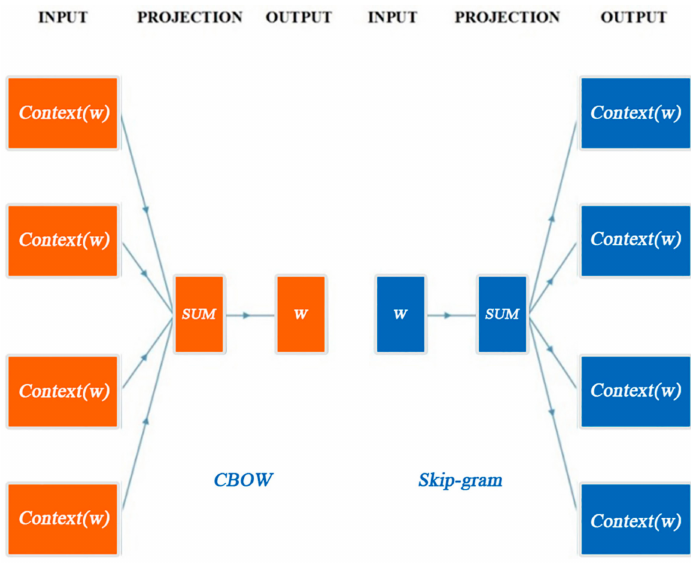
Figure 4. Model structure of CBOW and